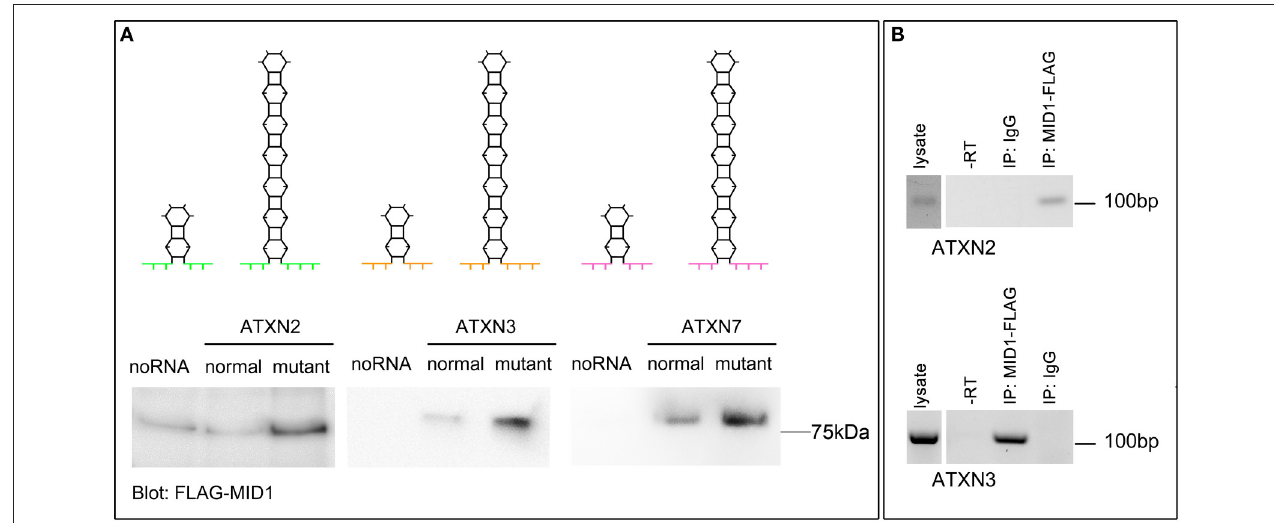
FIGURE 1 | MID1 binds to CAG repeat RNAs irrespective of the repeat-flanking sequences. (A) The binding of three different CAG repeat RNAs to MID1 was analyzed. Upper panel: schematic showing the predicted hairpin folding as well as the different CAG repeat flanking regions of ATXN2, ATXN3, and ATXN7 to visualize the different RNA fragments that were used, different colors symbolize the different flanking regions. Lower panel: in vitro transcribed fragments of ATXN2 , ATXN3 , and ATXN7 containing either normal or mutant CAG repeats were incubated with MID1-FLAG containing lysates. RNA-bound MID1 protein was analyzed on western blot using FLAG-antibodies. A representative western blot of n = 3 experiments is shown. (B) RNA-immunoprecipitation was performed in lysates from either mouse embryonic fibroblasts expressing mutant ATXN2 or primary neurons of a SCA3 mouse model that expresses full-length human ATXN3 with a mutant CAG repeat. MID1 was immunopurified and the presence of ATXN2 (upper panel) or human ATXN3 (lower panel) in the MID1 complex was tested by RT-PCR on RNA that co-purified with MID1. As negative control, a sample with unspecific IgG was used. As additional negative control a–RT reaction was performed. RT-PCR products were analyzed on an agarose gel. A representative gel of n = 3 experiments is